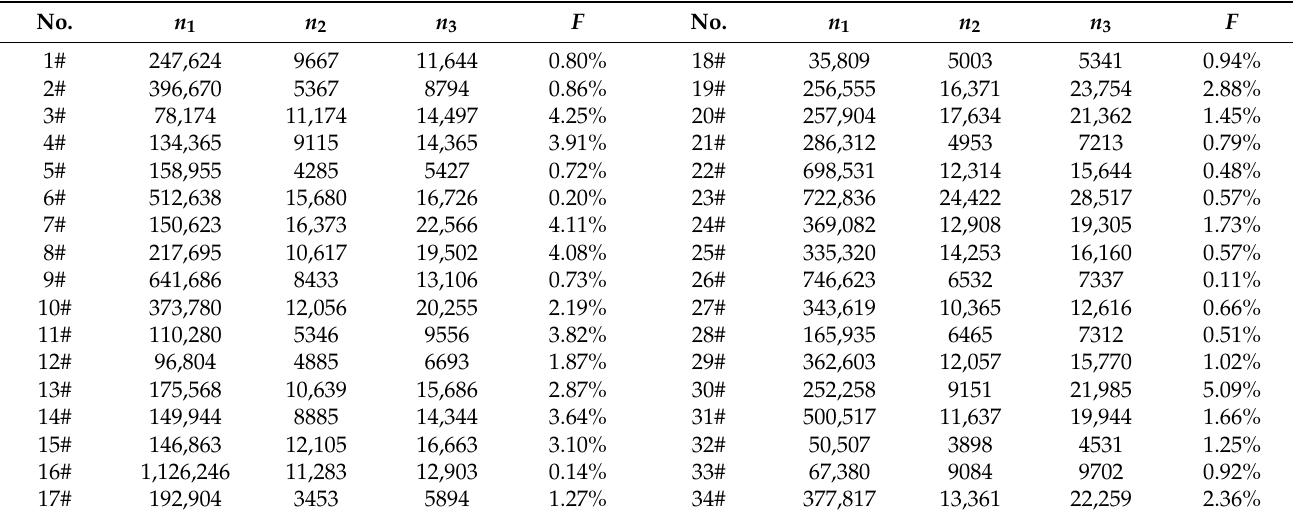
Table 1. Extraction results of anchor rod points in each cluster.